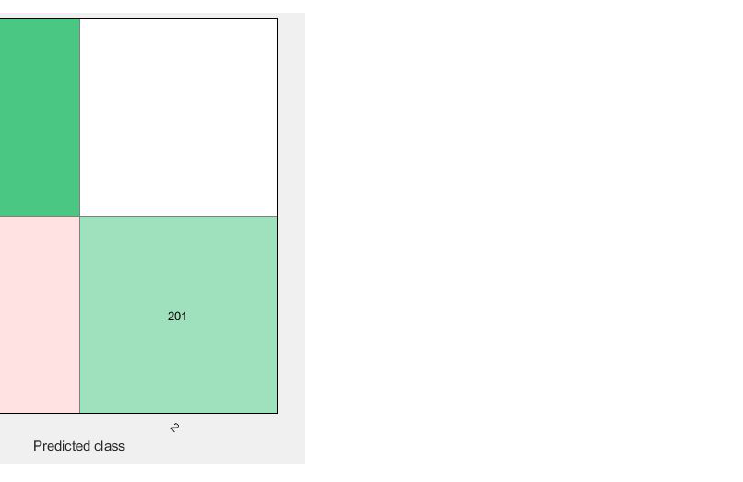
Figure 11. Confusion matrix of parallel fusion using 10-fold classification with Cubic–SVM.